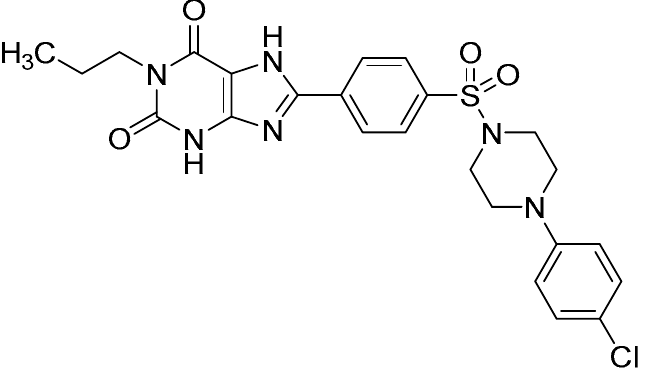
Figure 1. Structure of the potent and selective A 2B adenosine receptor antagonist PSB-603.